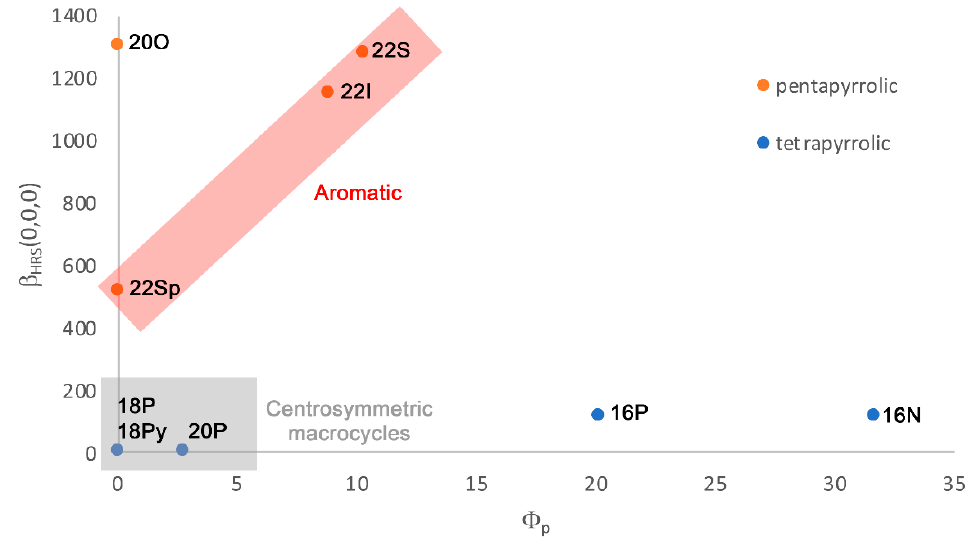
Figure 12. Dependence of the static β HRS values (in a.u.) with the macrocycle size and the planarity of the macrocycle, as denoted by the torsional strain ( Φ p in °). For centrosymmetric structures, β HRS equals 0.